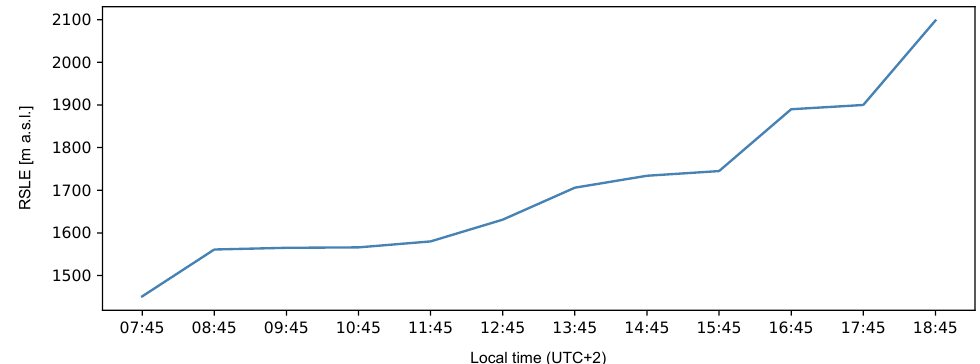
Figure 11. Daytime variability of the regional snow line elevation (RSLE) on 24 October 2017. The RSLE values were estimated using hourly webcam images.